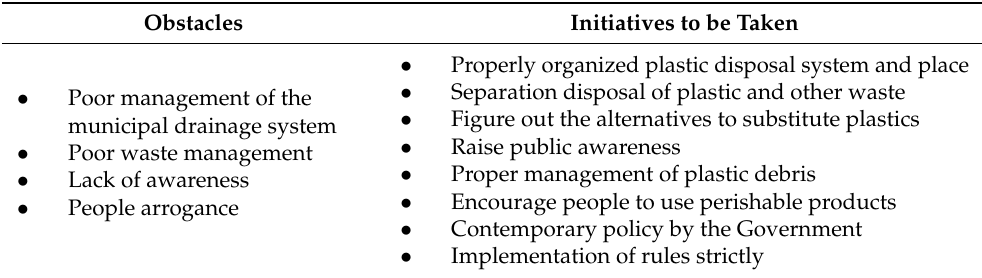
Table 6. Obstacles in minimizing plastic pollution and future